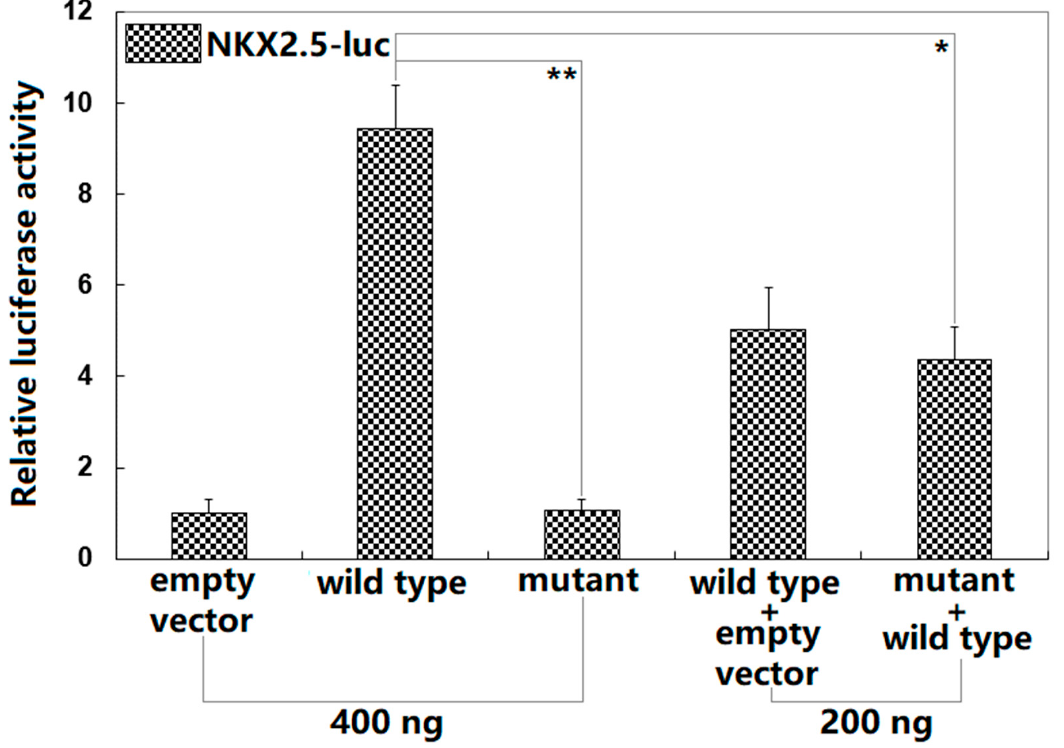
Figure 4. Functional failure of BMP10 caused by the Gln56* variation. The dual-reporter analysis of the transactivation of the NKX2.5 promoter-driven luciferase expression in cultured HeLa cells by wild-type BMP10 (wild type) or Gln56*-mutant BMP10 (mutant), singly or in combination, revealed that the mutant lost transcription activity. For each expression plasmid used, three independent transfection experiments were carried out in vitro in triplicate. The student’s unpaired t -test was employed to compare the two groups. Herein * and ** indicate p < 0.0005 and p < 0.005, respectively, in comparison with the wild type (400